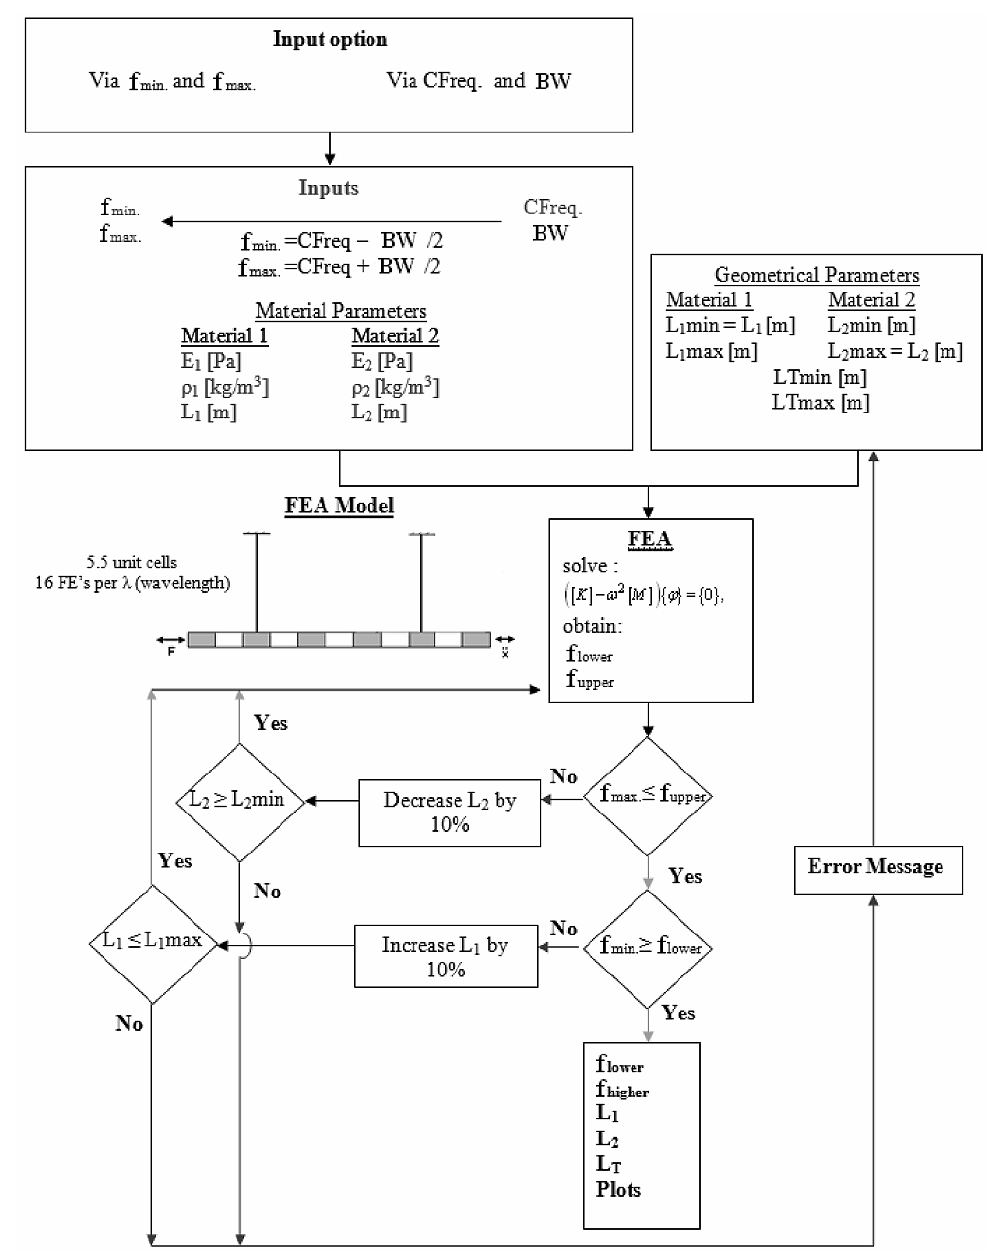
Fig. 5. Diagram of the design procedure/method applied to the design of a unit